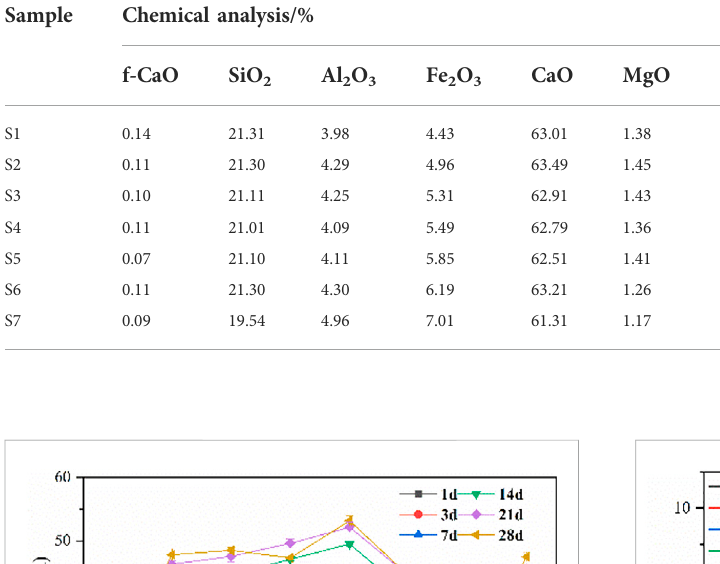
TABLE 6 Chemical composition analysis of the cement clinker.